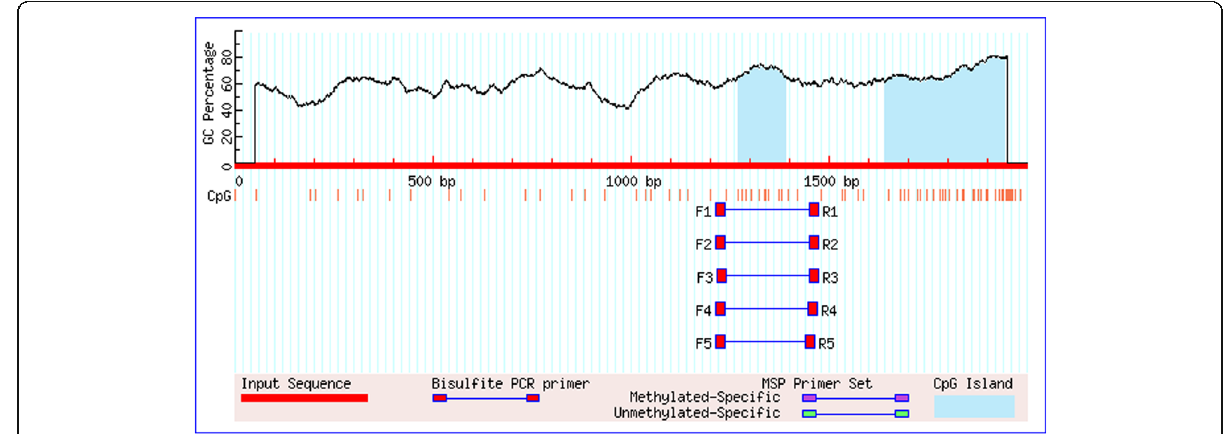
Fig. 12 Methylated CpG island map in the promoter region of the human PRRT2 gene predicted by the MethPrimer